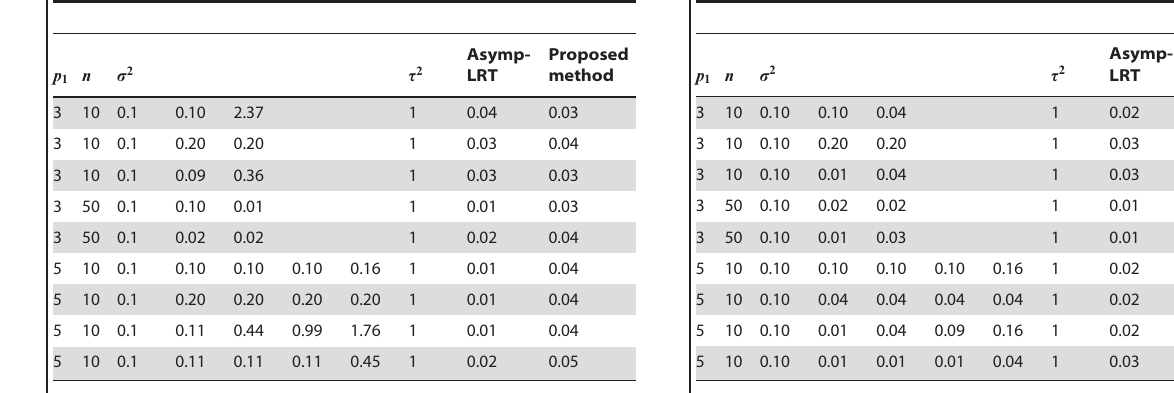
group, up to three 26-day courses were administered. Cao et al. Table 5. Type I errors for log-normally distributed